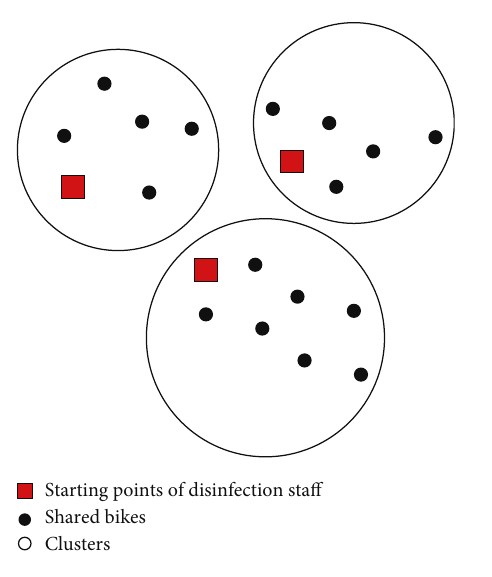
Figure 2: Clusters of shared